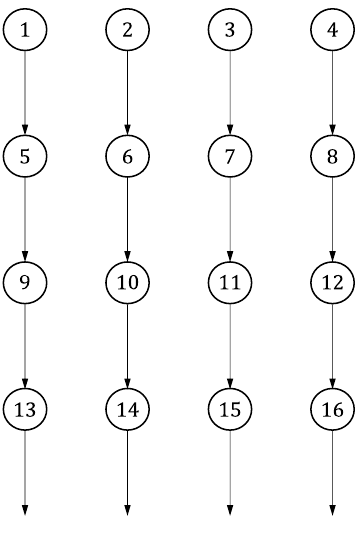
FIG. 12. Graph structure of the auxiliary Hamiltonian H aux